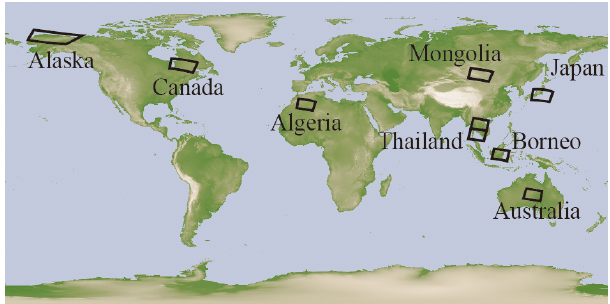
Figure 3. Study areas for various land cover types. Black rectangles indicate the locations of CAI